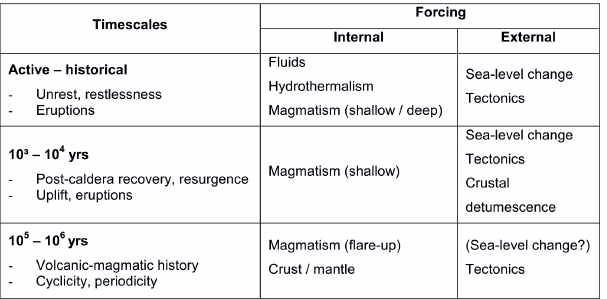
Figure 5. Timescales and forcing involved in the Campi Flegrei Amphibious Drilling Proposal